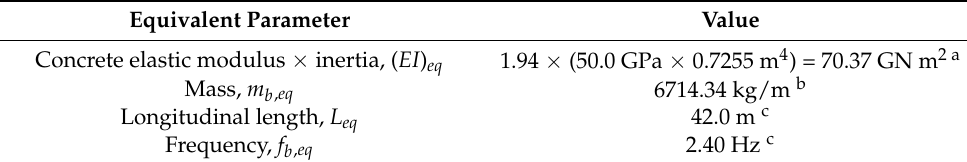
Table 3. Equivalent longitudinal beam data. Equivalent Parameter Value Concrete elastic modulus × inertia, ( EI )